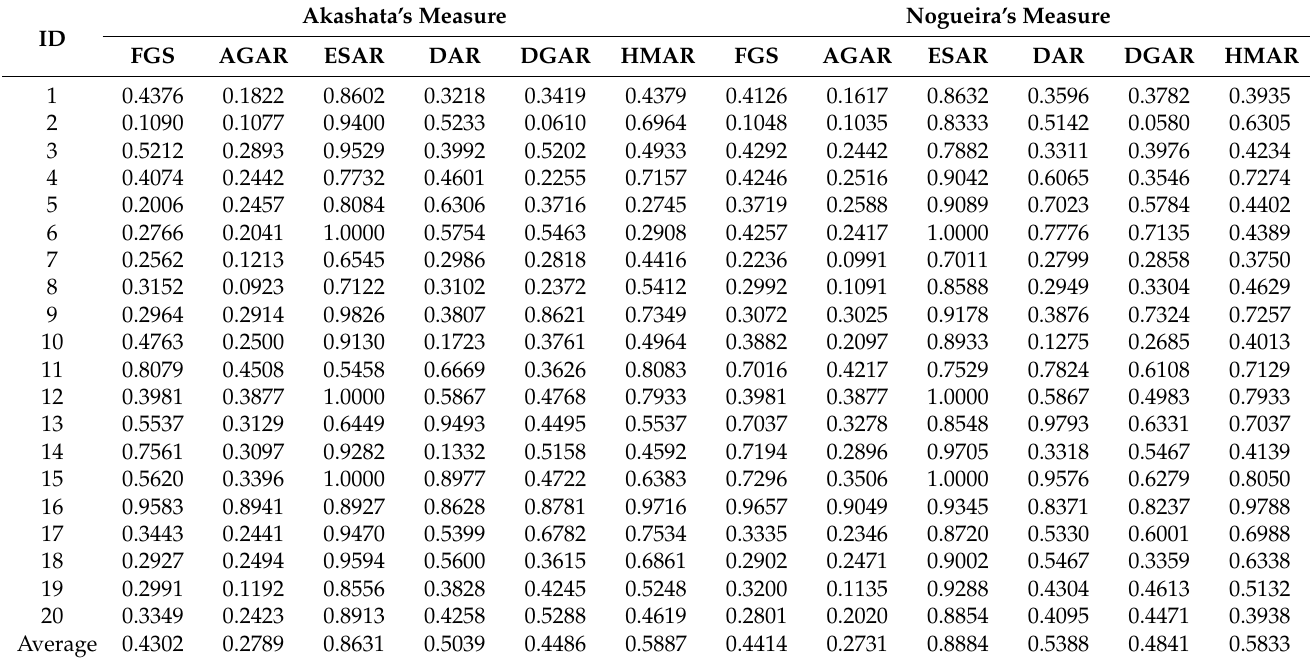
Table 2. Stability of reducts based on different